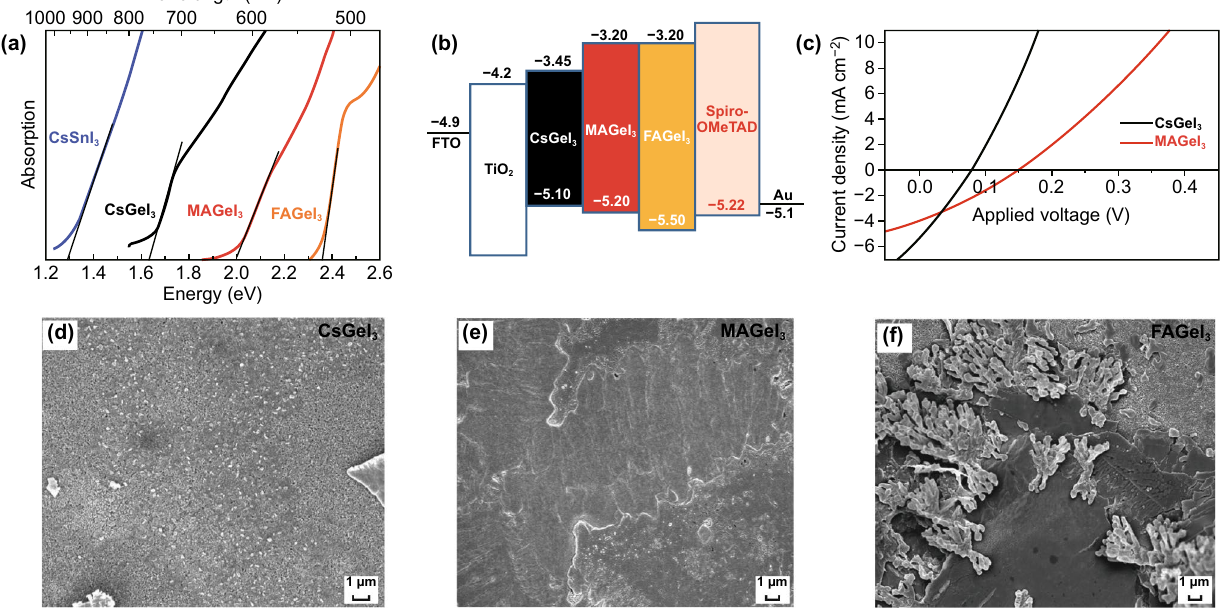
Fig. 9 a Tauc plot for CsSnI 3 , CsGeI 3 , MAGeI 3 , and FAGeI 3 showing optical bandgaps of 1.29, 1.63, 2.0, and 2.35 eV, respectively. b Energy level pattern for the PSCs with CsGeI 3 , MAGeI 3 , and FAGeI 3 absorbers. c Comparison of J – V curves of CsGeI 3 and MAGeI 3 solar cells. d‑f SEM images for CsGeI 3 , MAGeI 3 , and FAGeI 3 films both deposited on the compact TiO 2 /mesoporous TiO 2 substrates. Reproduced with permis- sion from Ref.